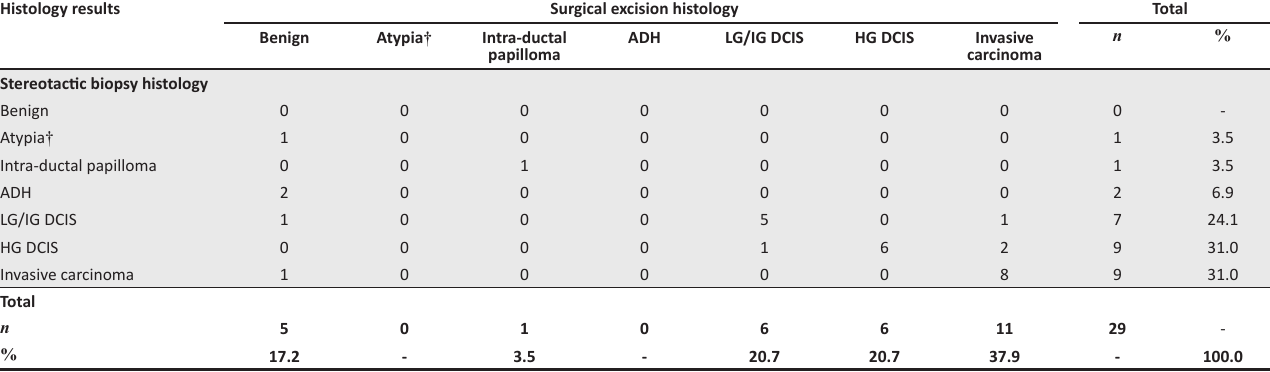
TABLE 4: Comparison of stereotactic biopsy histology with surgical excision histology. Histology results